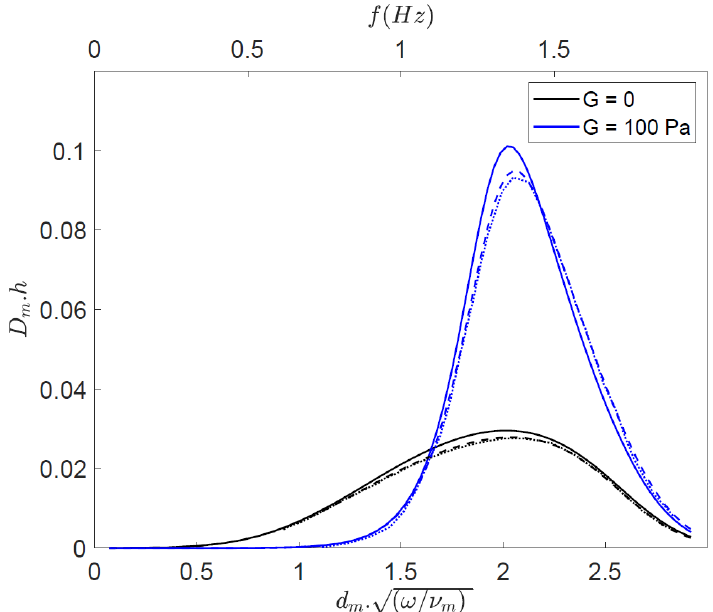
Figure 10. Variation of surface wave damping rate with frequency for different values of mud shear modulus. Solid line: Fr = + 0.15 m/s, dot line: Fr = 0, and dashed line: Fr = − 0.15 m/s, ζ = 100, h = 2.00 m, d m = 0.20 m, and ρ m = 1111 kg/m 3